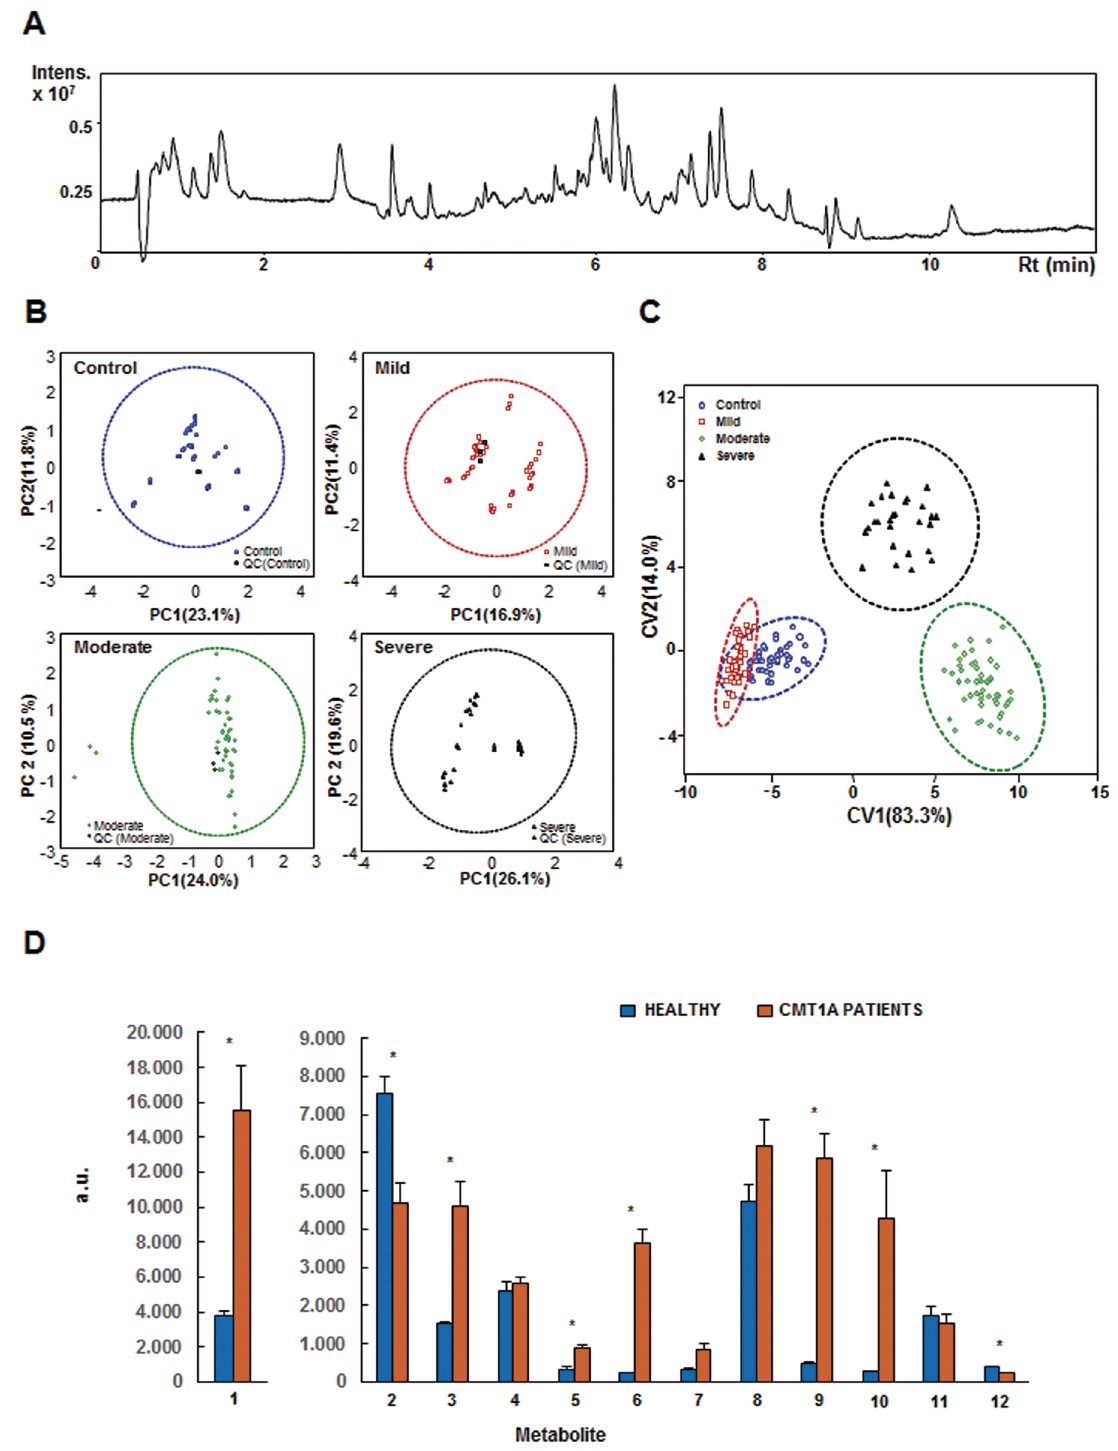
Fig 1. Analysis of plasma metabolome in CMT1A patients. (A), Representative UHPLC-MS total ion chromatogram of plasma samples.(B), Plot in a two-dimensional Cartesiancoordinatesystem, with the axes (principalcomponents,PC) representing the greatest variations in the data of Control (blue), Mild (red), Moderate (green) and Severe (black) states related to CMT1A. Three qualitycontrol (QC) injectionsper group are also representedin the plot for the four groups of individuals. 95% confidenceellipsesare also included. Triplicate outliersof one of the samples in the Moderate group fall out of the ellipse.